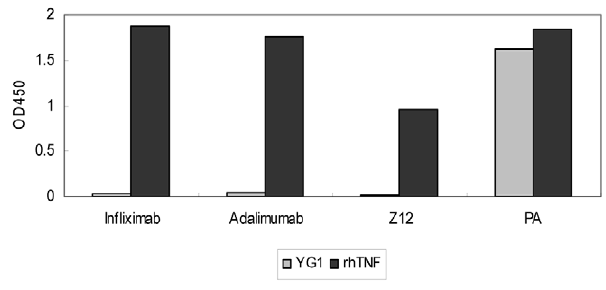
Figure 2. The interaction between different antibodies and YG1. The synthesized peptide according to YG1 and rhTNF- a were individually coated. Different antibodies were added, Infliximab, Adalimumab and Z12 referred to three monoclonal antibodies, while PA was the polyclonal antibodies against rhTNF- a . The results were expressed as OD value at 450 nm. The experiment was performed twice.